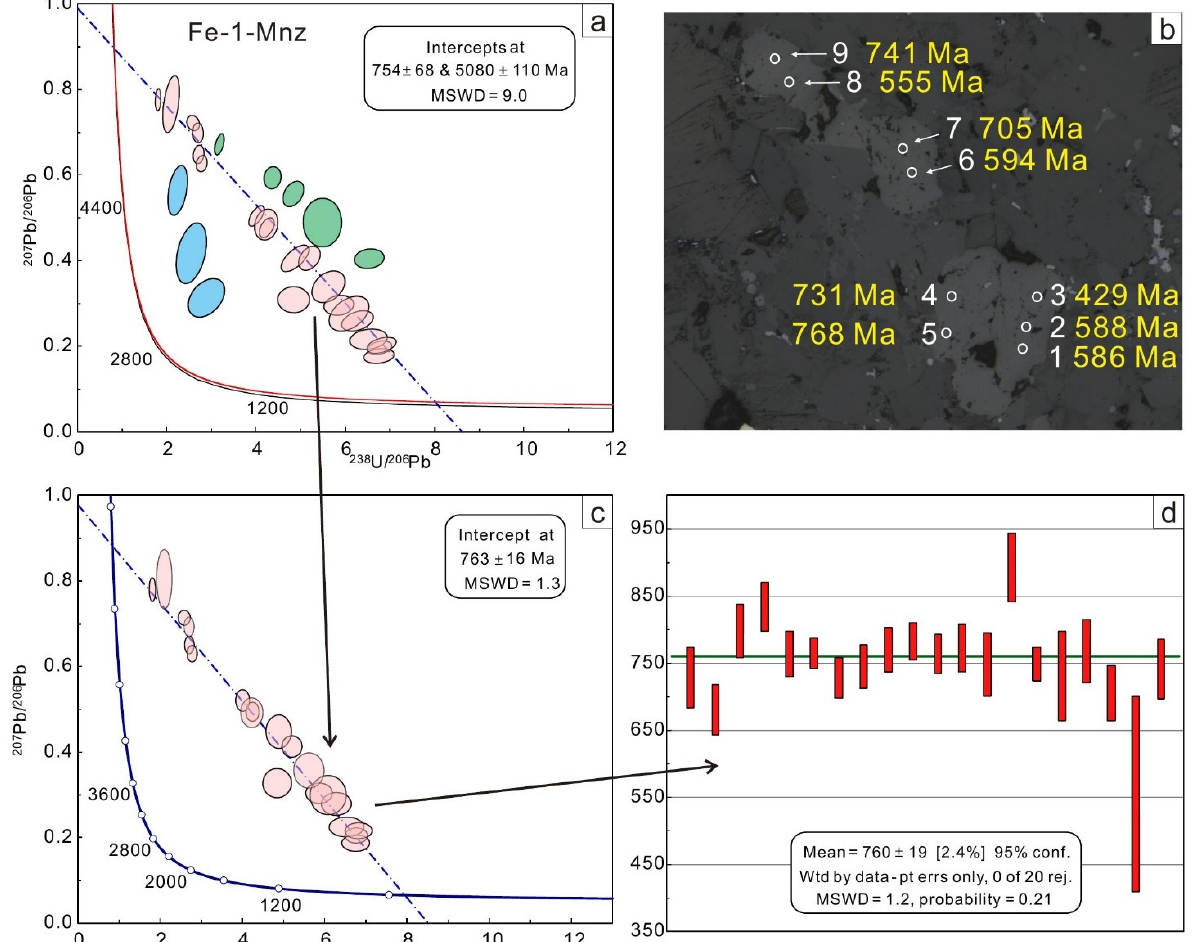
Figure 9. Monazite Concordia diagram of sample Fe-1 from the Bayan Obo deposit. ( a ) The Intercept age of all dates. ( b ) The detail testing locations and age distribution characteristics in monazite. ( c ) The Intercept age of the pink group. ( d ) The mean age dates of the pink group. The monazite in sample B-2 has coarse-grained crystals with sizes up to 300 um. U–Pb dating of the coarse-grained crystal site yielded an intercept 207 Pb age of 689 ± 22 Ma (MSWD = 8.1). The ages (22 dates) can also be divided into two groups: 651 ± 15 Ma (MSWD = 2.5) and 723 ± 14 Ma (MSWD = 2.2). Some monazite grains show old cores and new rims. The maximum and minimum ages of a single point were 818 ± 31 Ma and 597 ± 15 Ma, respectively (Table 3 and Figure 10). Table 3. Monazite U–Pb isotopic data of the sample B-2 from the Bayan Obo deposit. Sample Ratios Error